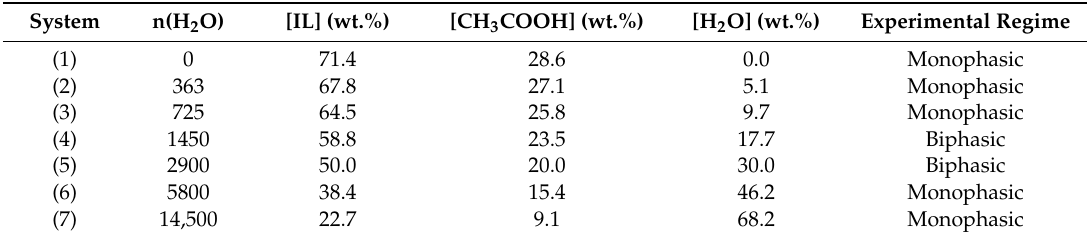
Table 2. [P 44414 ]Cl + CH 3 COOH + H 2 O system composition for all AA simulations at 323 K. All systems contain 200 [P 44414 ]Cl ion pairs and CH 3 COOH molecules with an increasing number of water molecules